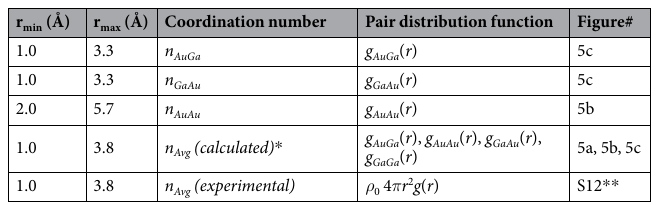
Table 3. The details of integrating procedure at coordination numbers calculation. * n Avg ( calculated ) = C Au [